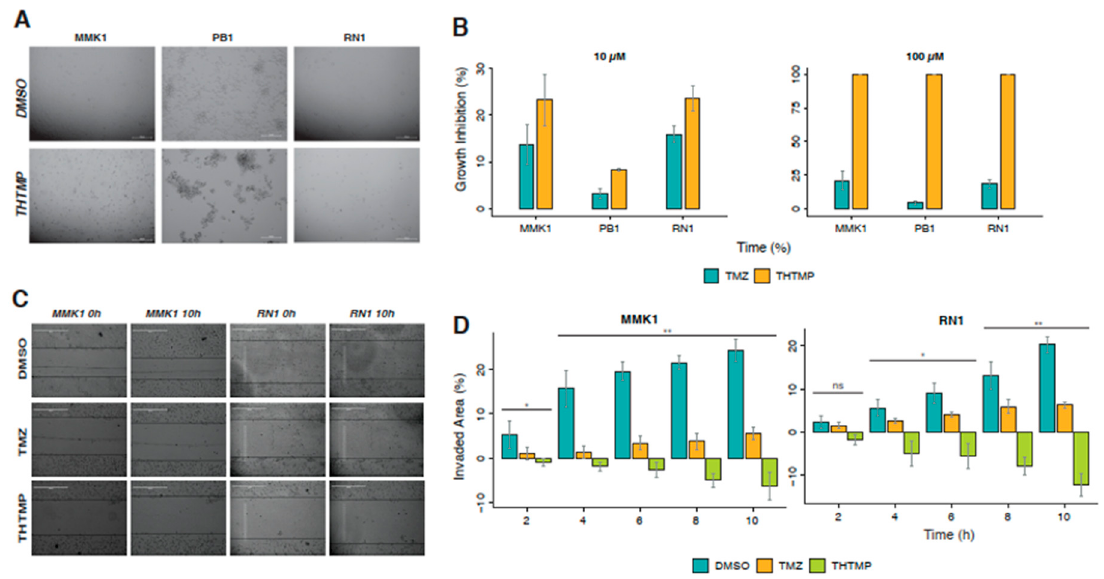
Figure 6. THTMP inhibited cell growth and cell migration of patient-derived mesenchymal subtype of GBM cells. ( A ) Demonstrated images of morphological changes in patient-derived GBM cells at 24 h after THTMP and DMSO treatment. ( B ). Growth inhibitory effect of THTMP on different cell lines, MMK1, RN1 and PB1 at 10 and 100 µM after 24 h post treatment. ( C ) Example images of scratch assay shows the closing/widening of the scratched area over the time. All images were taken using a light microscope with 10× objective. ( D ) Quantification of the percentage of invading area of MMK1 and RN1 cells for every 2 h over the period of 10 h after the scratch. * p < 0.05, ** p < 0.01, ns—non